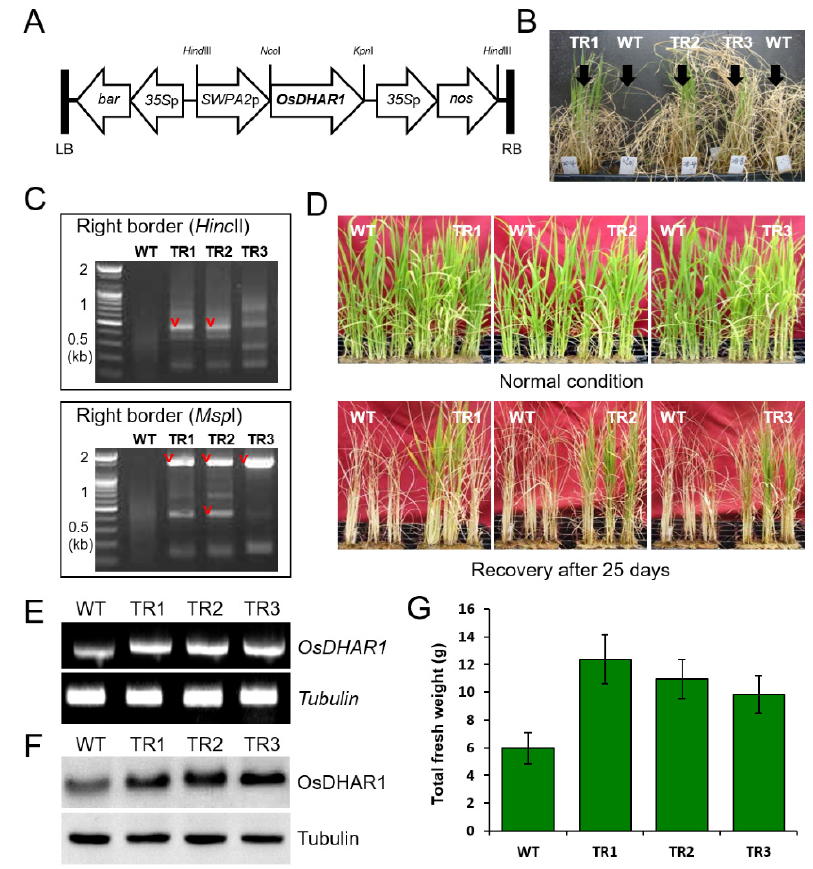
Figure 1. Production and salt stress response of OsDHAR1 -expressing transgenic rice plants. ( A ) Schematic diagram of the OsDHAR1 gene construct. SWPA2 :: OsDHAR1 includes a sweet